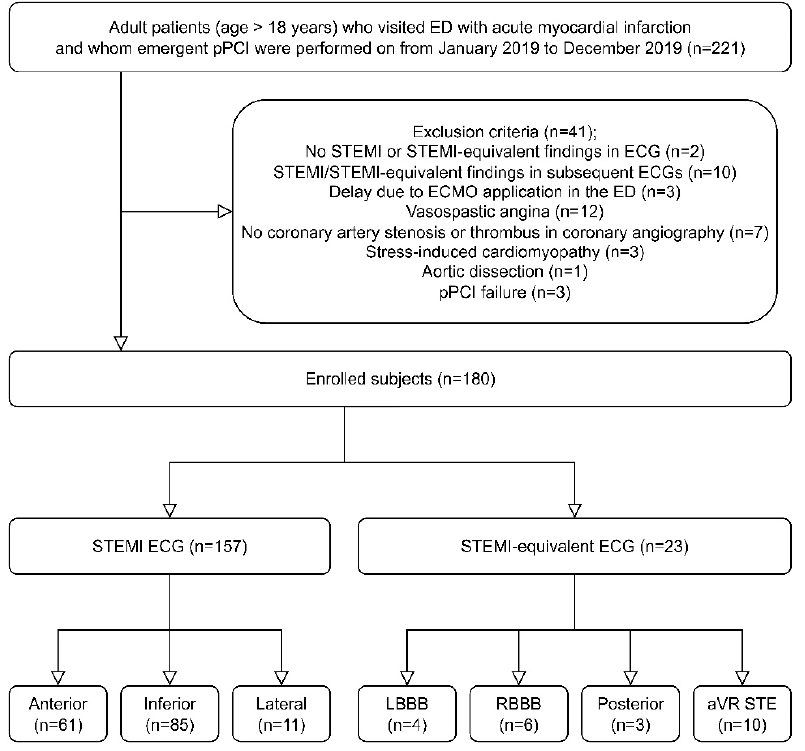
Figure 1. Flow chart of this study. Abbreviations: ECG, electrocardiogram; ECMO, extracorporeal membrane oxygenation; ED, emergency department; LBBB, left bundle branch block; pPCI, primary percutaneous coronary interventions; RBBB, right bundle branch block; STE, ST-segment elevation; STEMI, ST-segment elevation myocardial infarction.